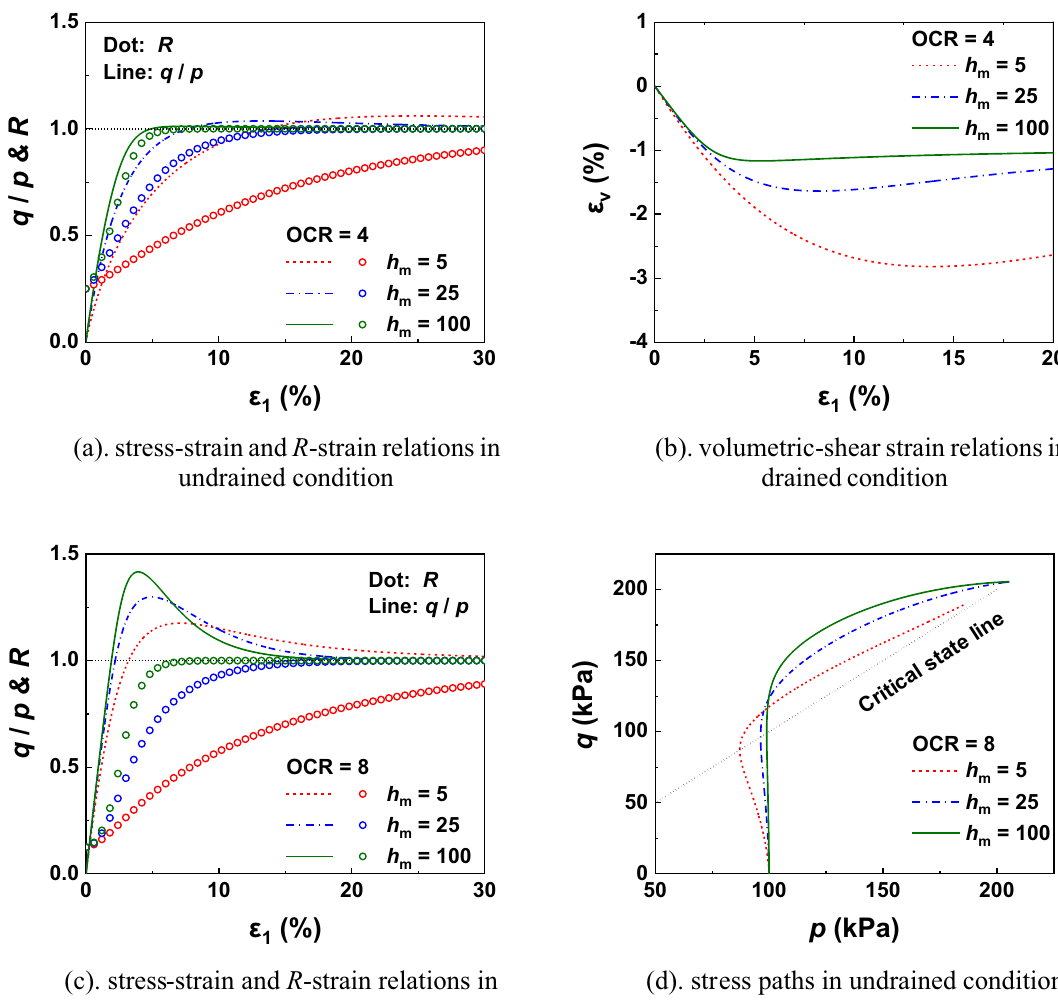
Figure 3. Drained and undrained simulations with different values of h m in monotonic loading